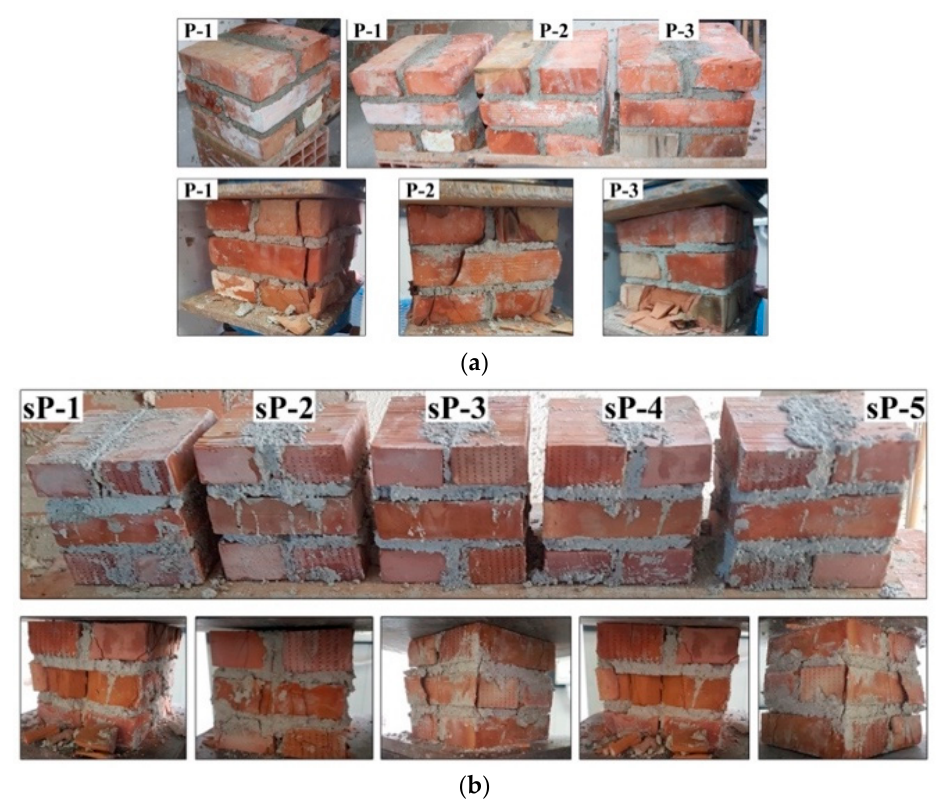
Figure 8 . Masonry prisms tested in compression (before and after testing): ( a ) full-scale brick and ( b ) half-scale brick. Table 4. Results of the material characterization tests.